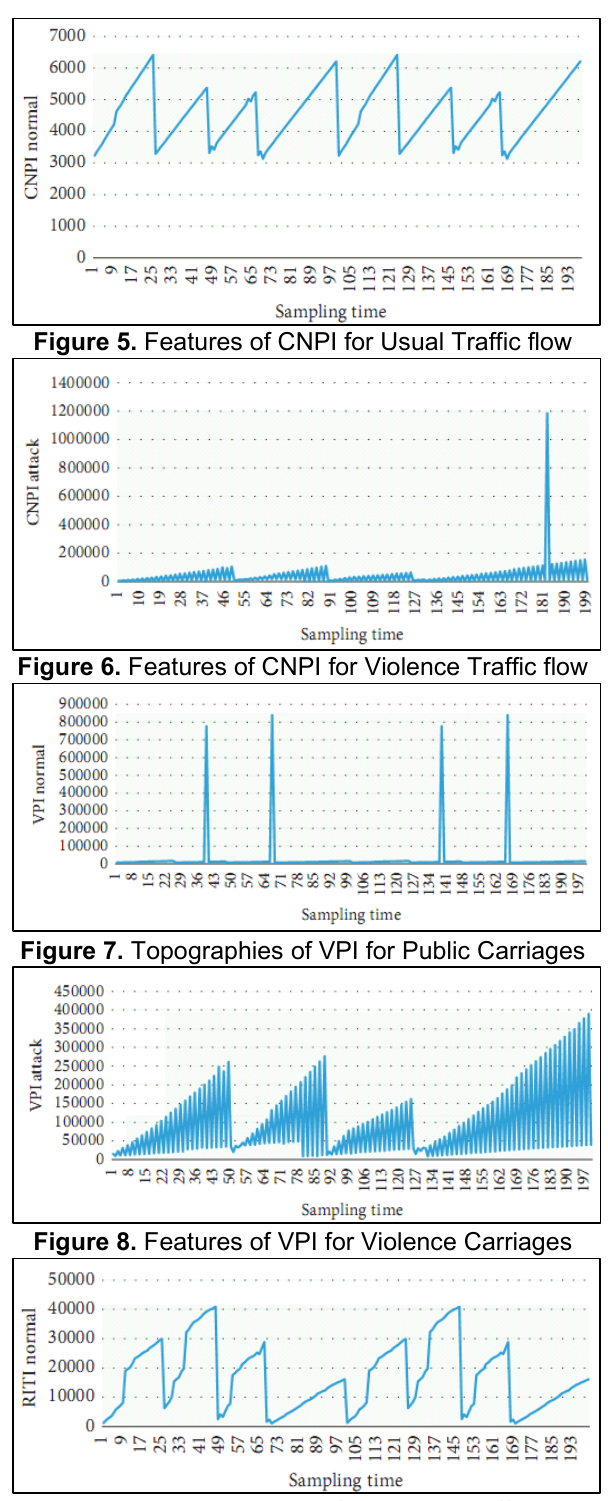
Figure 9. RITI Features for Normal